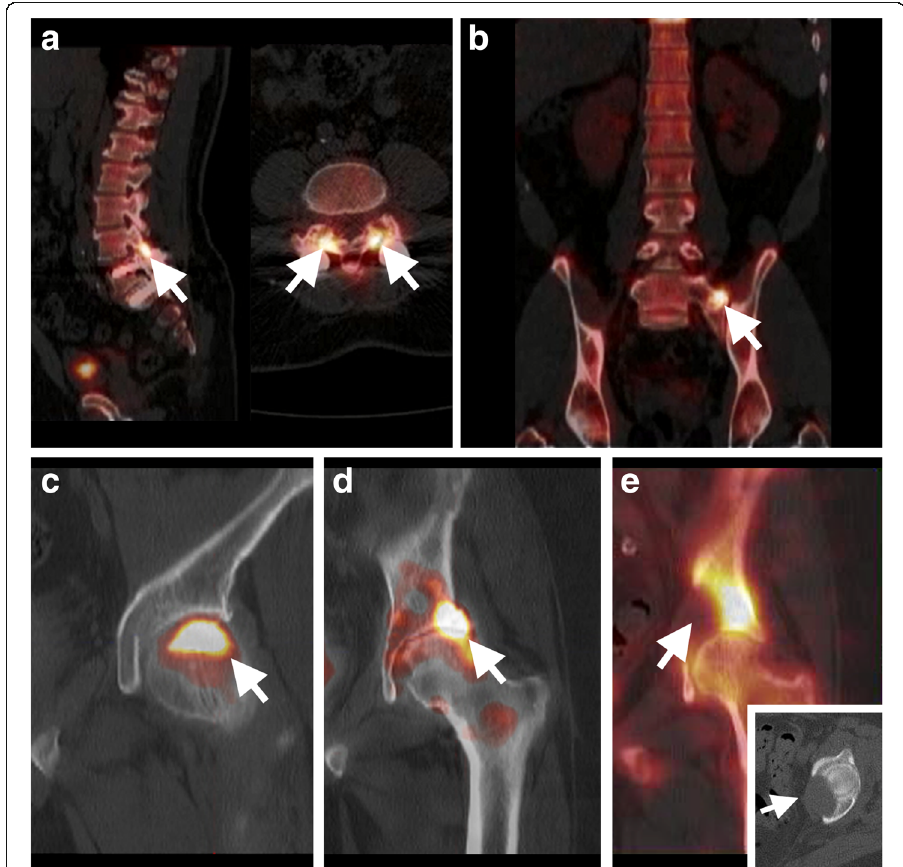
Fig. 7 Bone SPECT/CT imaging of referred pain. Illustration of bone SPECT/CT applications in imaging of conditions associated with referred pain: a degenerative facet joint arthropathy in the segment above spinal fusion, b symptomatic Bertolotti ’ s syndrome, and focal uptake in the hip where SPECT/CT imaging allows differentiation of c avascular necrosis, d osteoarthritis, and e an osteolytic bone metastasis and soft- tissue component